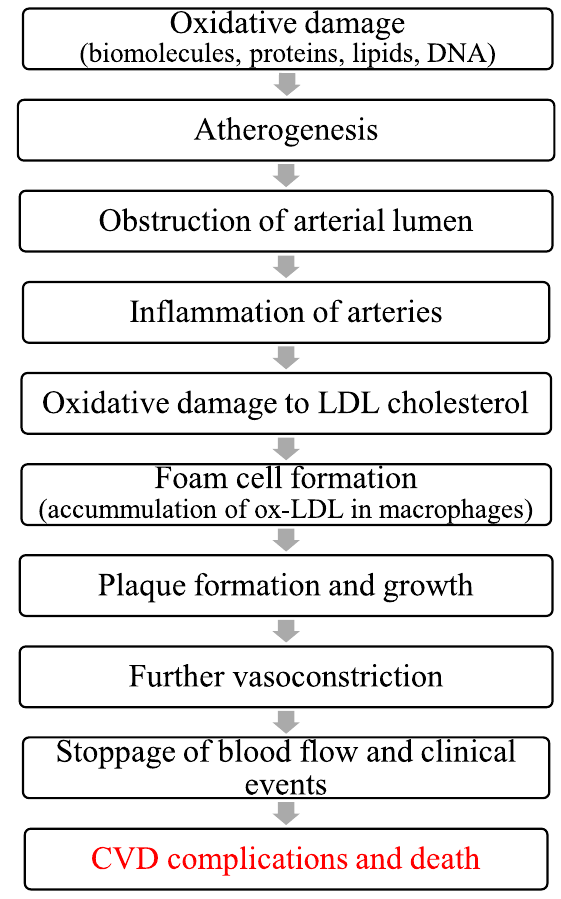
Fig. 1 Pathophysiology of oxidative damage induced cardiovascular disease (CVD) complications and death. DNA (deoxyribonucleic acid), LDL (low density lipoprotein), ox-LDL (oxidized low-density lipoprotein), CVD (cardiovascular